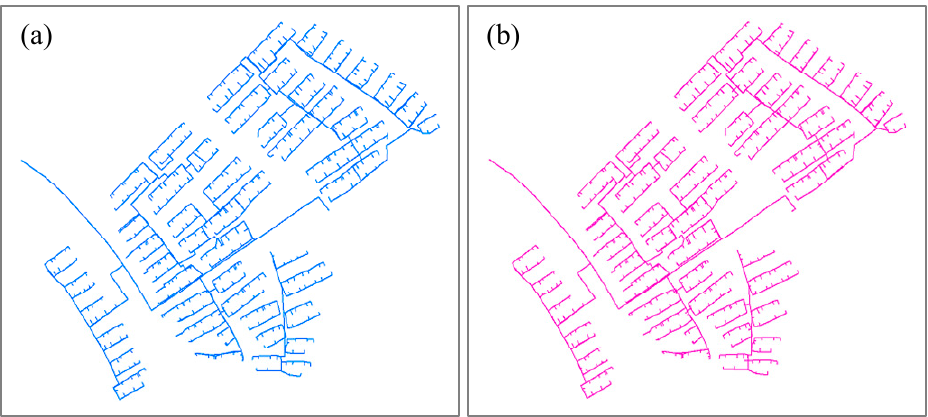
Figure 10. ( a ) The integrated pipeline (gas) map with pipelines shown in blue; ( b ) the professional pipeline (gas) map with pipelines shown in pink.